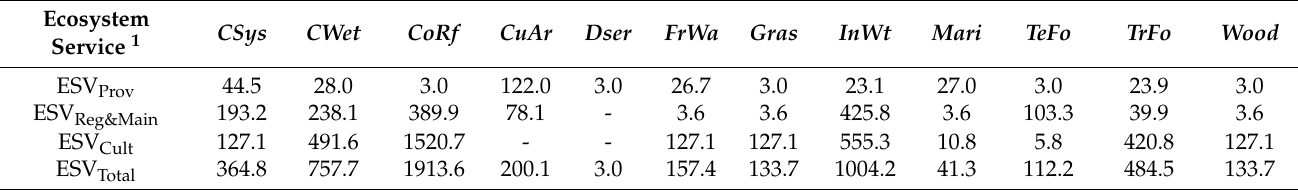
Table 9. Estimated ES values per biome for Provisioning (ESV Prov ), Regulating and maintenance (ESV Reg&Main ), and Cultural (ESV Cult ) ecosystem services, using Local meta function transfer and mean national values for the explanatory variables (in 2015 €